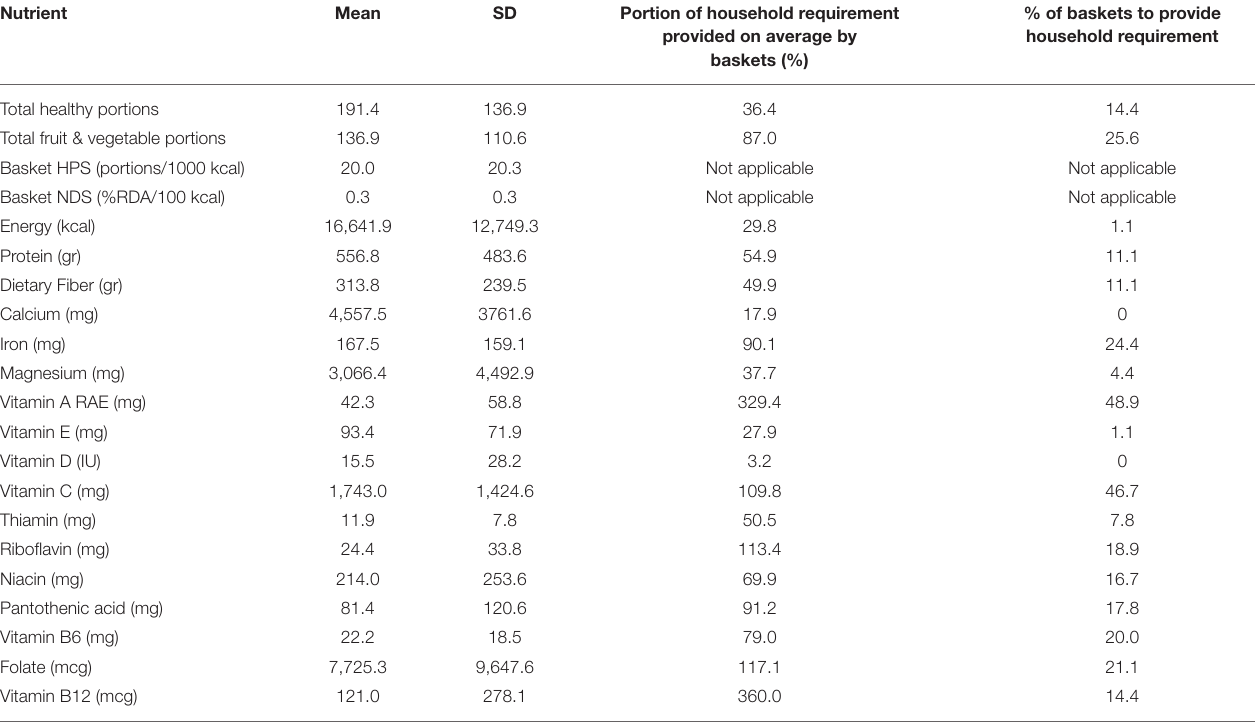
% of baskets to provide provided on average by household requirement baskets (%)